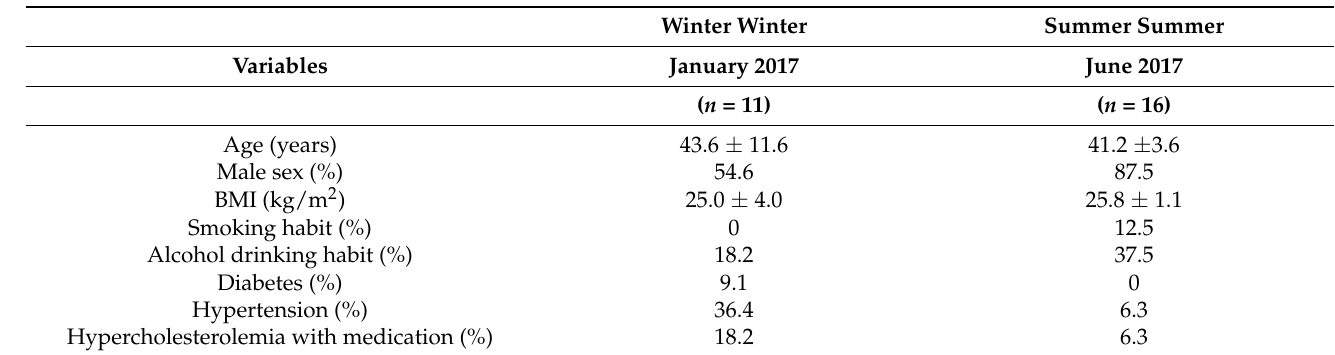
Table 1. General characteristics among participants